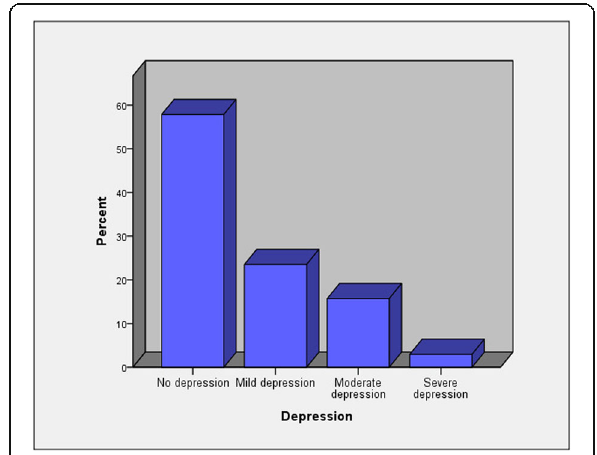
Fig. 1 Frequency of post-COVID depression among study